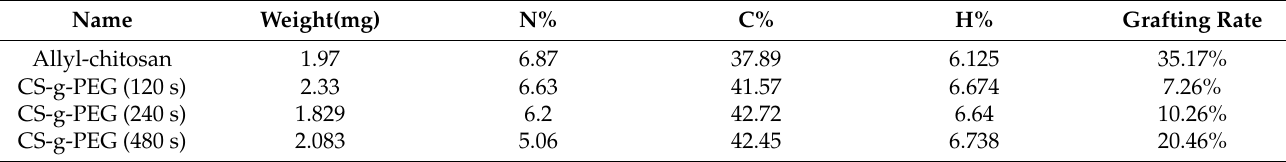
Table 1. Elemental analysis of allyl-chitosan and CS-g-PEG 120, 240 and